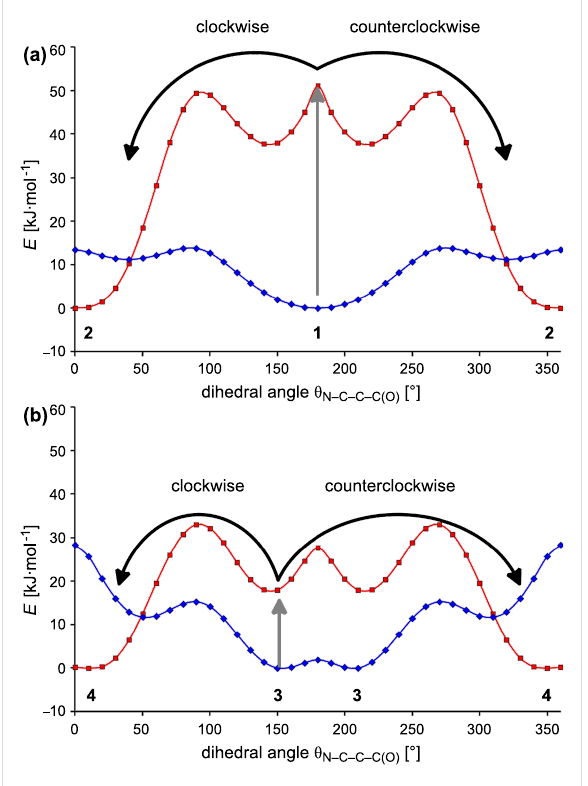
Figure 1: (a) Calculated energy profiles of the pyridine derivatives 1 (blue) and 2 (red) in relation to the dihedral angles θ N–C–C–C(O) by use of B3LYP/6-31G*. (b) Calculated energy profiles of the pyridine deriva- tives 3 (blue) and 4 (red) in relation to the dihedral angles θ N–C–C–C(O) by use of